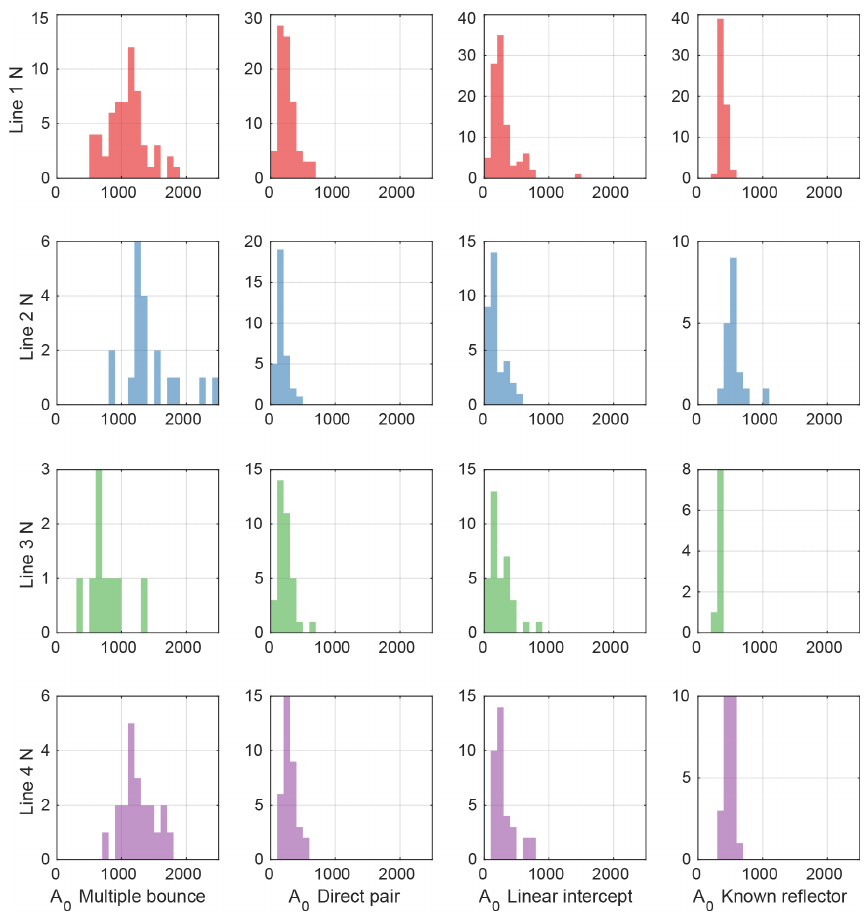
Figure 4. A 0 source size estimates for Whillans grounding zone lines 1–4 (rows) using four methods (columns). Left column: A 0 estimates using the primary–multiple amplitude ratio method. Centre left column: A 0 direct pair estimates. Centre right column: A 0 linear intercept estimates. Right column: A 0 estimates from known reflection coefficient method assuming ice overlying water. (See Fig. 1 for line locations.)